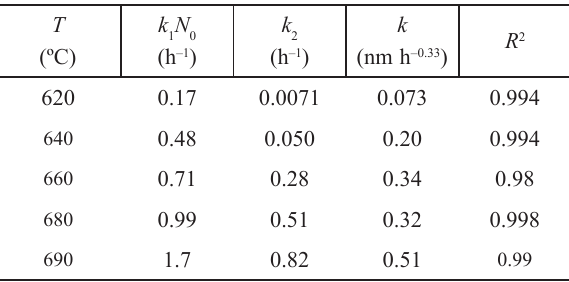
Table 2 – Parameters for the kinetic model (9) with m = 3, for transformation from anatase to rutile (Fig. 3)